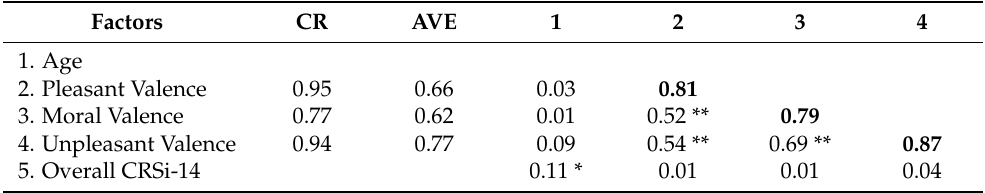
Table 4. Discriminant validity and correlation matrix for participants’ age, EtG subscales, and overall